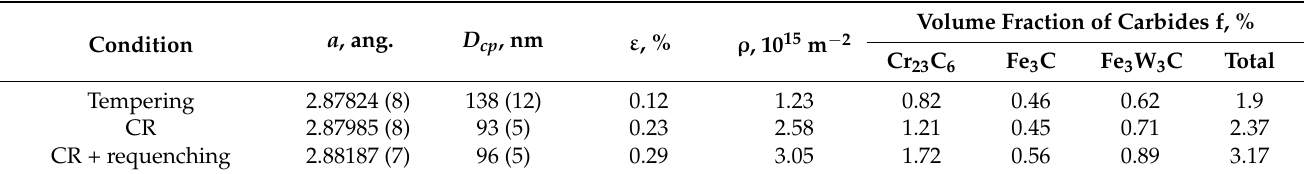
Table 3. Microstructure parameters from X-ray diffraction analysis. Measurement errors related to the last significant digit are indicated in